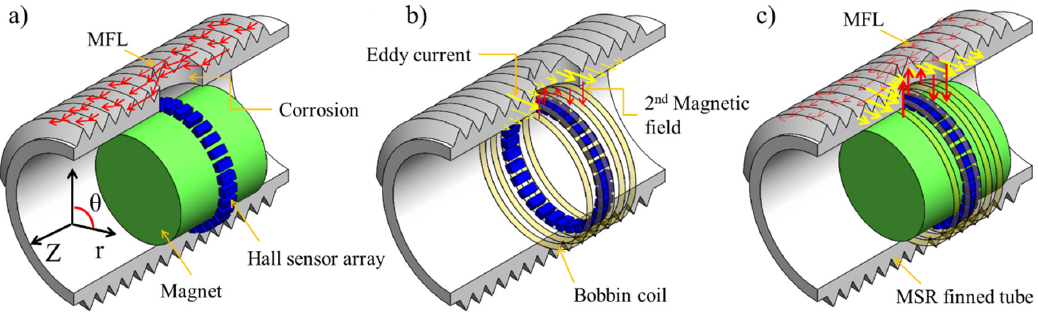
Figure 1. Electromagnetic testing of the moisture separator reheater (MSR)-finned tube. ( a ) Magnetic flux leakage testing (MFLT); ( b ) eddy current testing (ECT) and ( c ) partial saturation eddy current testing (PSECT).